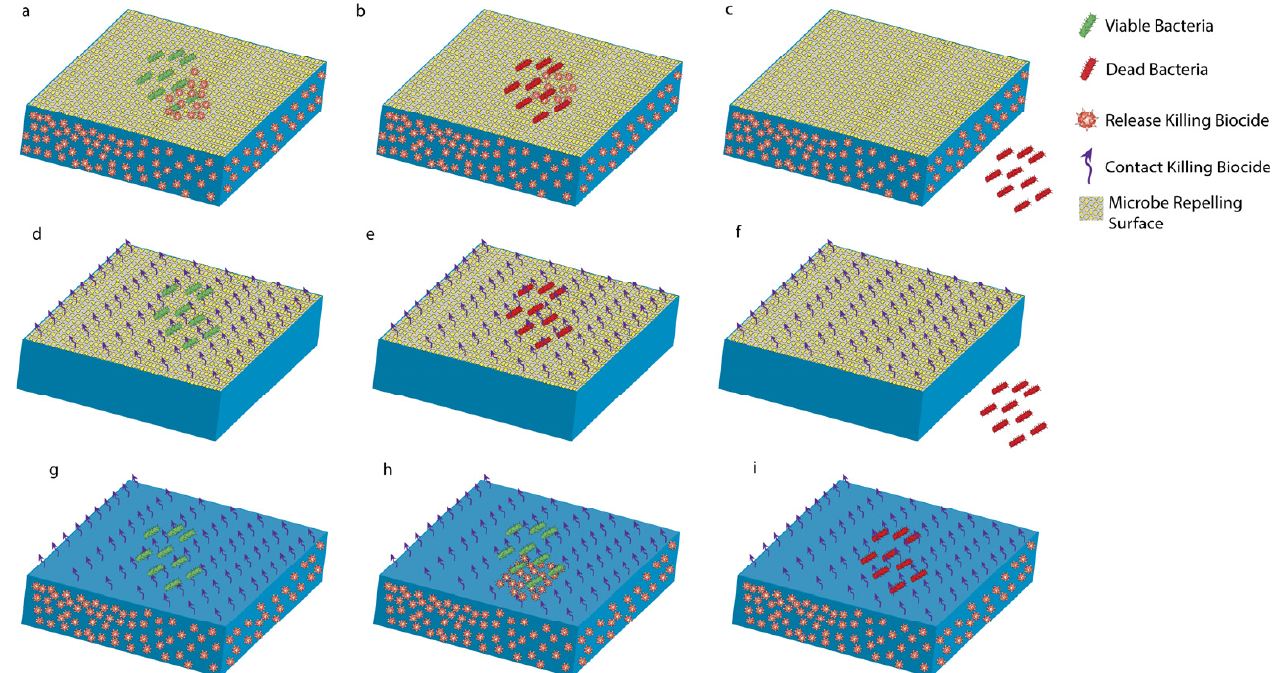
Figure 4. Types of antimicrobial coatings. Releasing and repelling coatings: (a) Bacteria encounter the surface. (b) Bacteria are killed by biocides released from the surface. (c) Self ‐ cleaning surface removes the dead cells. Contact ‐ killing and repelling coatings: (d) Bacteria encounter the surface. (e) Bacteria killed upon contact. (f) Self ‐ cleaning surface removes the dead cells. Releasing and con ‐ tact ‐ killing coatings: (g) Bacteria encounter the surface. (h) Bacteria killed by both biocides. (i) Dead bacteria stay on the surface until cleaned.